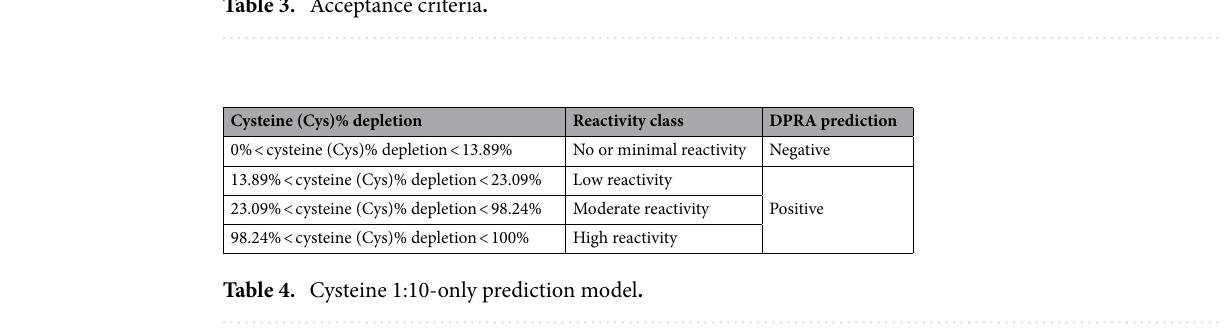
Table 3. Acceptance criteria .